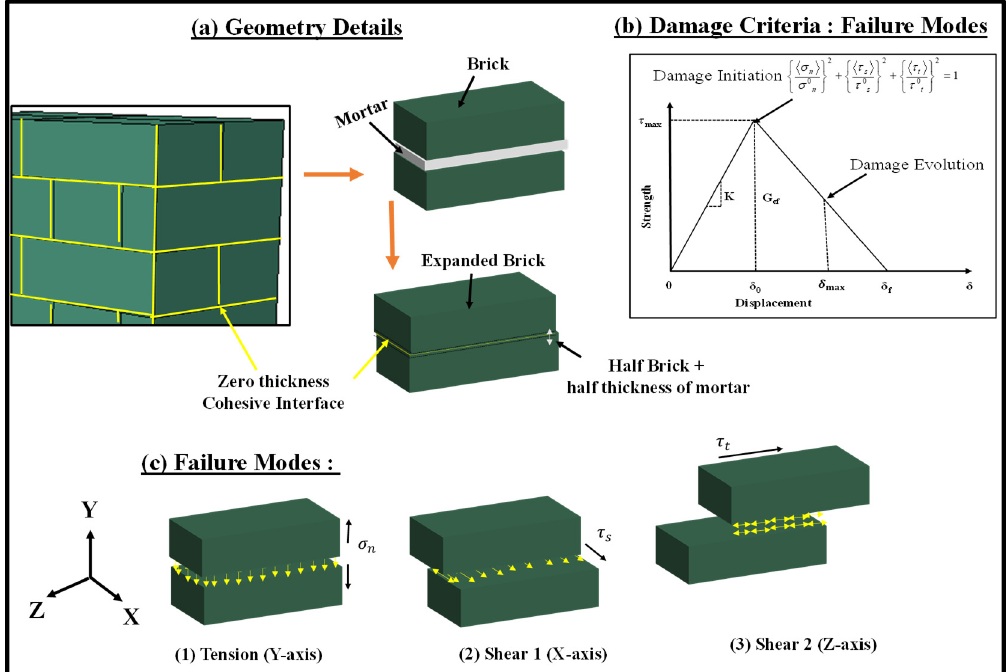
Figure 5. Zero-thickness Cohesive Interface model details; ( a ) geometry details, ( b ) damage criteria at interface and ( c ) failure modes at the interface.